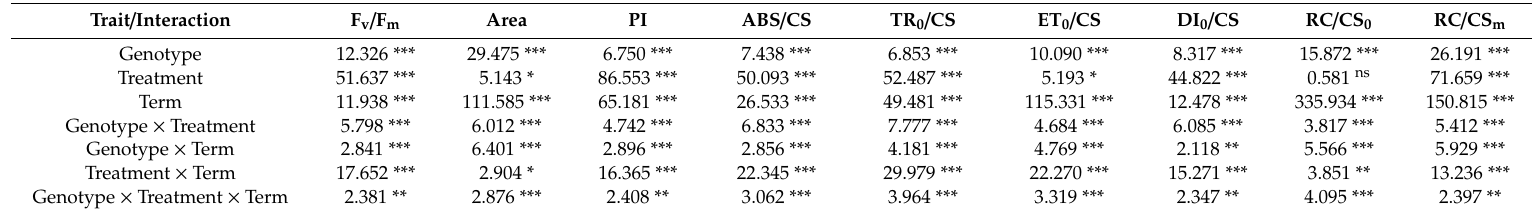
Table 4. F -statistic from three-way analysis of variance for chlorophyll a fluorescence parameters of studied genotypes (OMA lines and cv. Bingo). Trait /